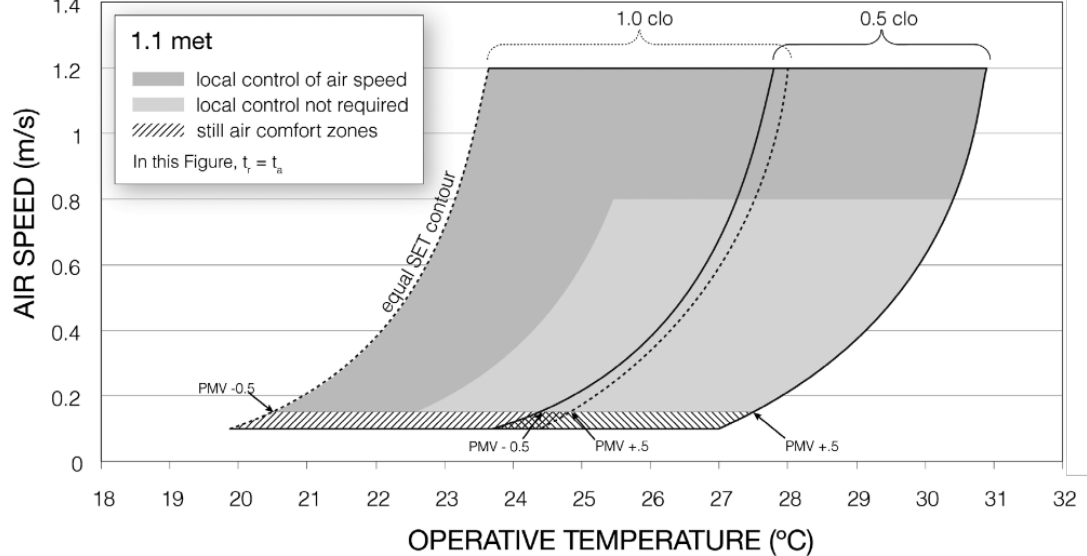
Figure 1. Acceptable range of operative temperature and air speeds for the comfort zone at humidity ratio 0.010 kg H 2 O/kg dry air. Adapted from [6].